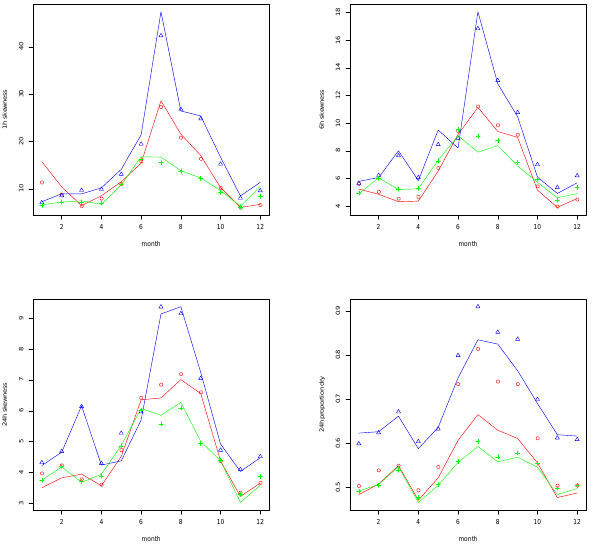
Fig. 5. Fitted (x) and observed (lines) skewness and proportion of dry days for the central region (red), southern region (blue) and north-eastern region (green). Table 3. Percentage of variance explained by the first five principal components of maximum daily temperature and total rainfall.